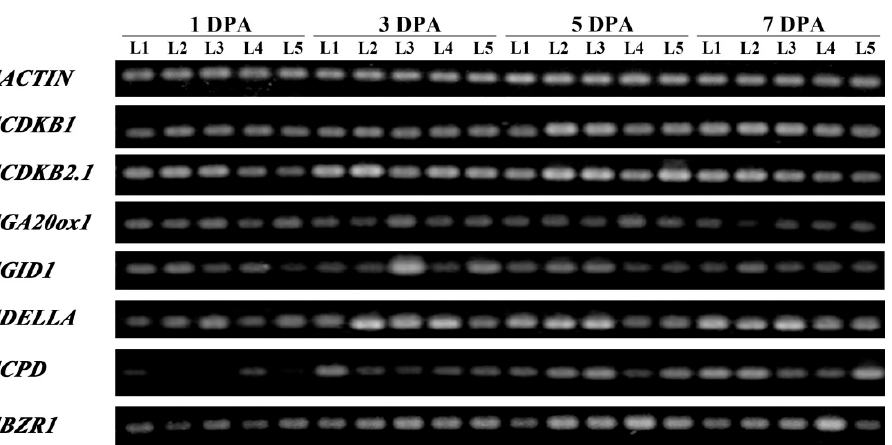
Figure 6. SlBRI1 T825A affects the expression of fruit growth-related genes. The relative transcript levels of fruit growth-related genes in ovaries at 1 DPA, 3 DPA, 5 DPA, and 7 DPA from both the transgenic and cu3 -abs1 plants were tested by RT-PCR. SlACTIN was used as a reference gene in tomato. L1 (Line 1), cu3 -abs1 ; L2 (Line 2), SlBRI1-1; L3 (Line 3), SlBRI1-3; L4 (Line 4), T825A-1; L5 (Line 5), T825A-2. Each product had 3 biological